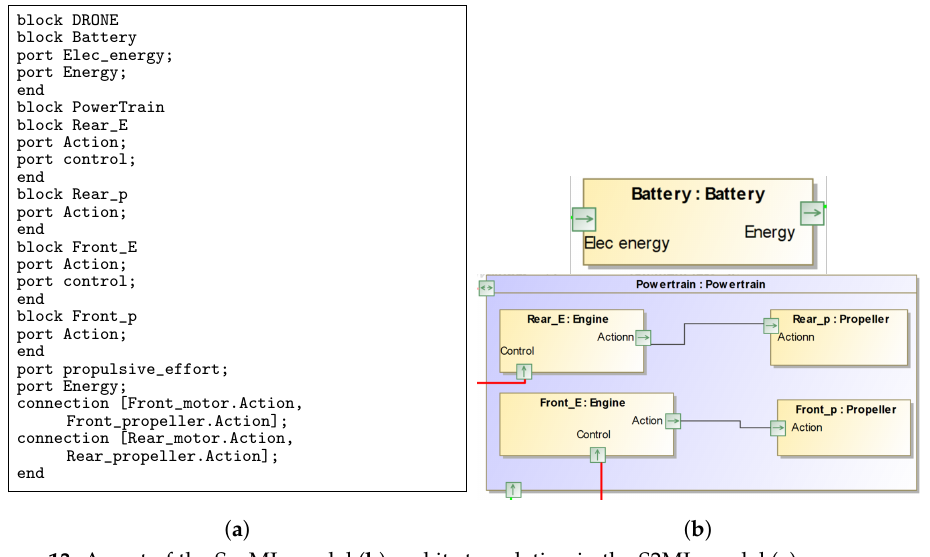
Figure 13. A part of the SysML model ( b ) and its translation in the S2ML model ( a ).